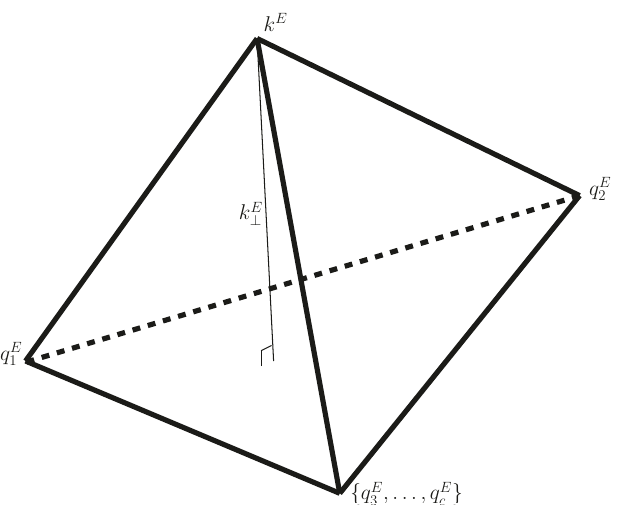
, with the transverse component k E Q C